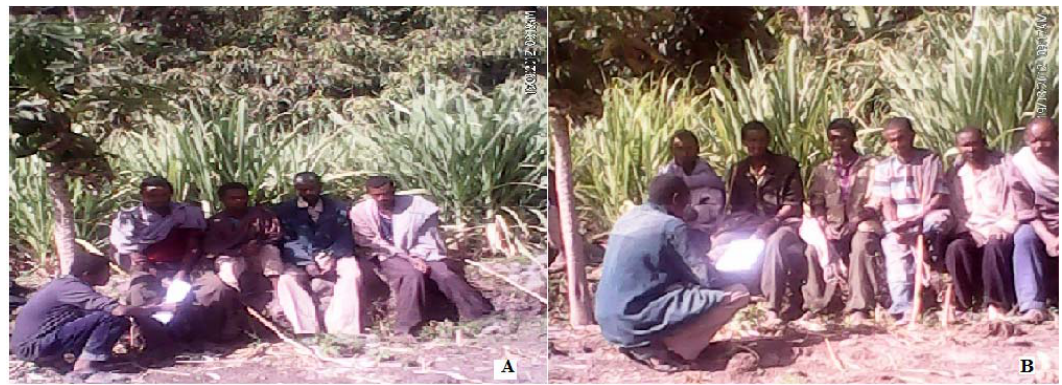
Figure 7. Photo graphs showing group discussion with the beneficiary households of Gedober irrigation scheme ( A and B ) March 2014